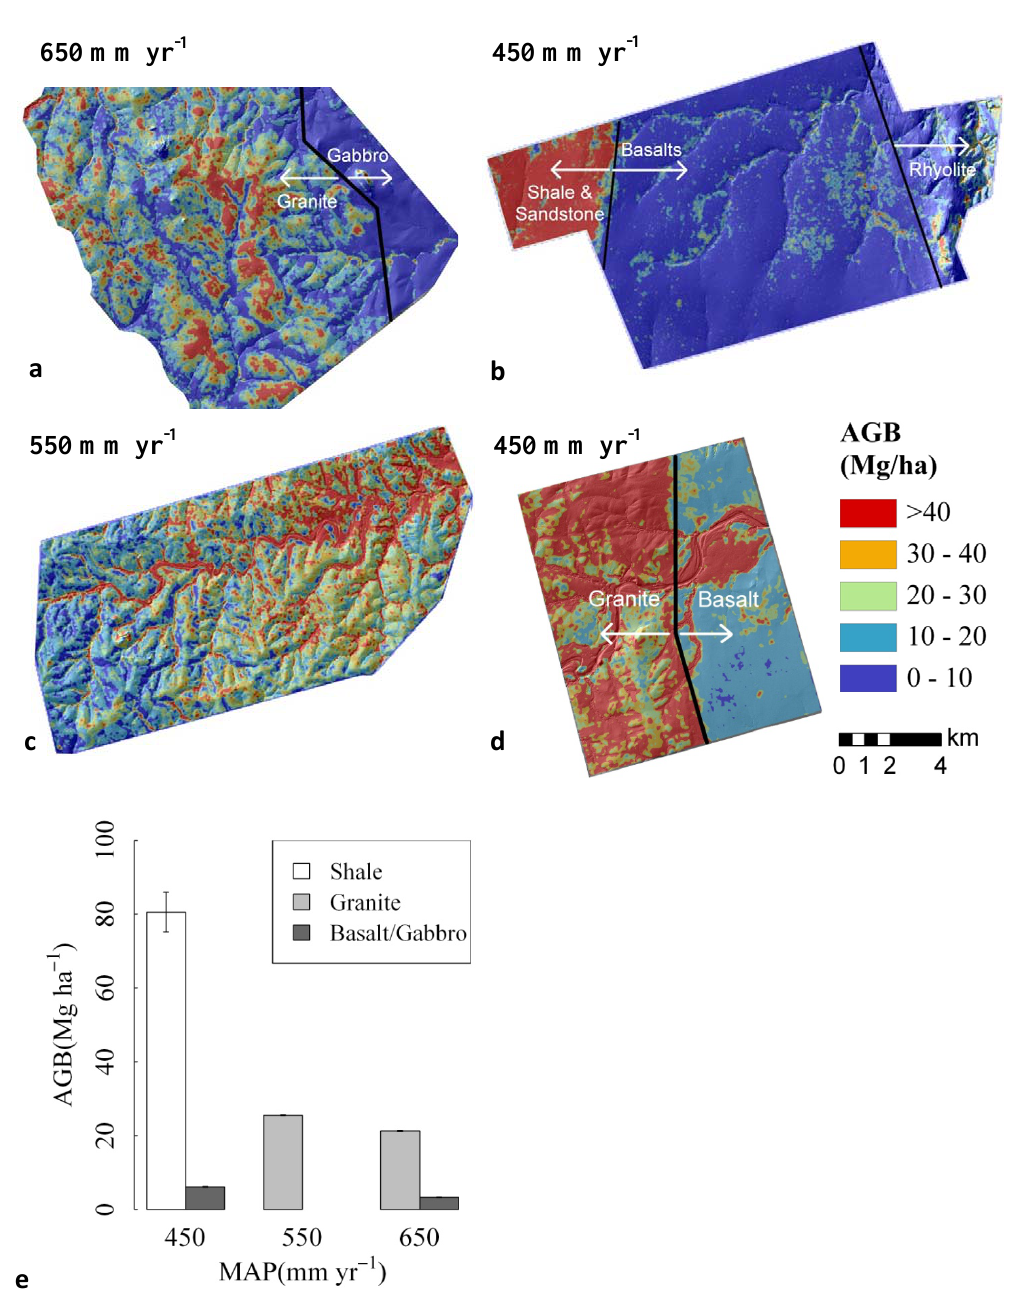
Fig. 4. LiDAR-derived AGB overlaying topographic hillshade for reference for four landscapes: (a) Pretoriuskop (b) Lower Sabie (c) Skukuza (d) Shingwedzi (e) Mean landscape AGB ( ± 2SE) across substrate and precipitation gradients, controlling for radiation, temperature, and species composition (excludes Shingwedzi due to different radiation and vegetation